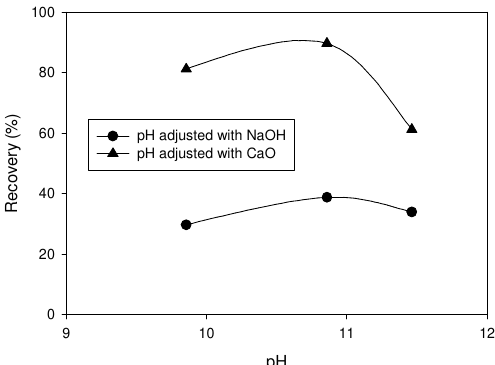
Figure 31. Pyrite recovery as a function of a pH adjusted with NaOH and CaO. Conditions: 1 × 10 −4 mol/L of CuSO 4 and 5 × 10 −5 mol/L of butyl xanthate (adapted from Li et al. [138]).